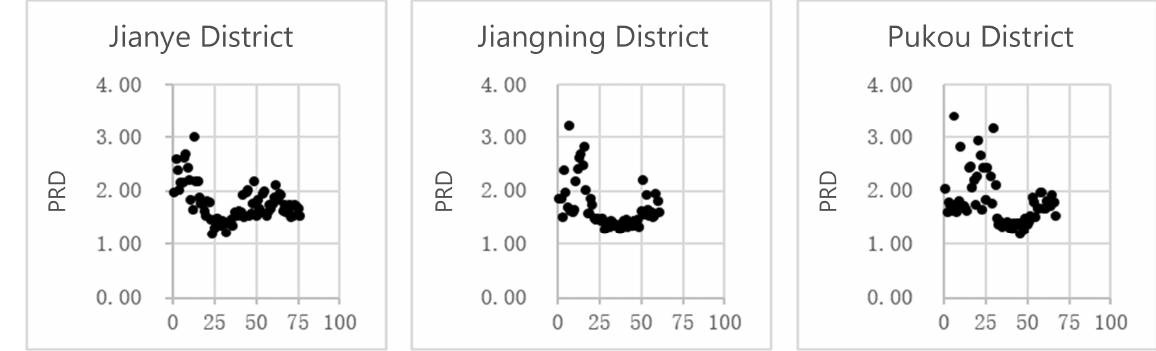
(5) Figure 12. Pedestrian Route Directness ( PRD ). In the ArcGIS software, the path analysis tool is used to calculate the linear distance and the shortest path distance of each residential sample from the geometric central point to the adjacent city intersection, and the PRD coefficient is calculated (Figure 13 and Table 8). From the results of data distribution, the average PRD value of residential areas in